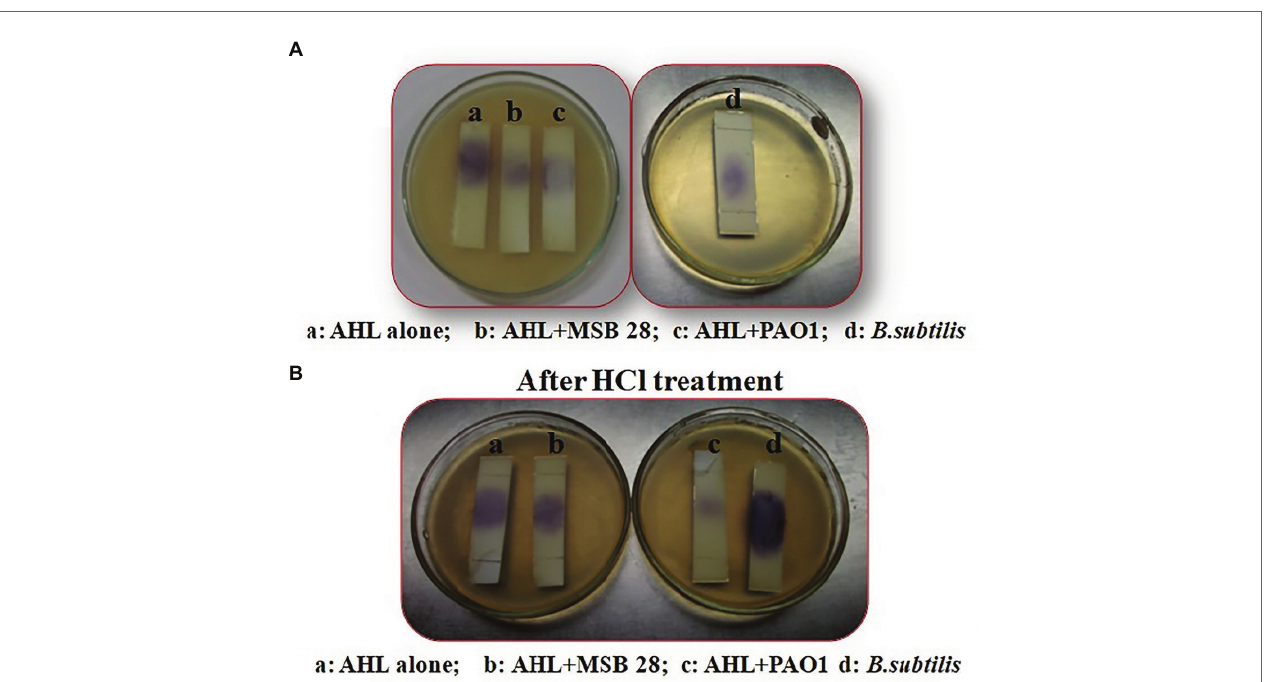
FIGURE 6 | (A) Analysis of mechanism of action of Psychrobacter sp. by ring closure assay. (B) Activity after HCL treatment. C 6 HSL alone (a) , degradation pattern of C 6 HSL by CFS of Psychrobacter sp., (b) PAO1 (c) , and B. subtilis (d)